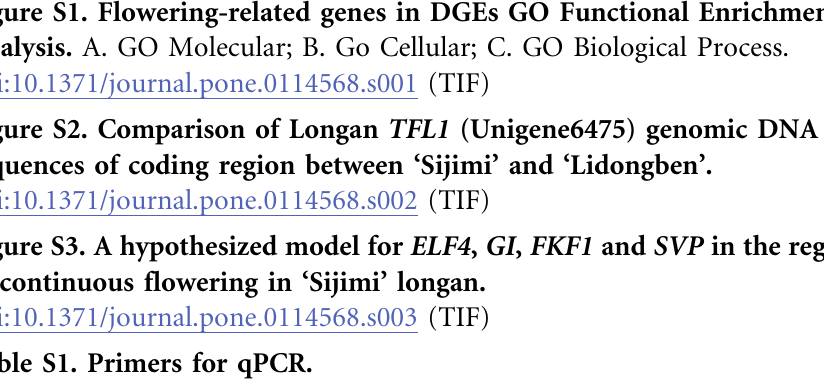
Figure S1. Flowering-related genes in DGEs GO Functional Enrichment Analysis. A. GO Molecular; B. Go Cellular; C. GO Biological Process. Figure S2. Comparison of Longan TFL1 (Unigene6475) genomic DNA sequences of coding region between ‘Sijimi’ and ‘Lidongben’. Figure S3. A hypothesized model for ELF4 , GI , FKF1 and SVP in the regulation of continuous flowering in ‘Sijimi’ longan. Table S1. Primers for qPCR. Table S2. Pathway enrichment analysis of significantly differentially expressed genes (DEGs) based on the Kyoto Encyclopedia of Genes and Genomes (KEGG). Table S3. Sequences of 107 flowering-time unigenes in